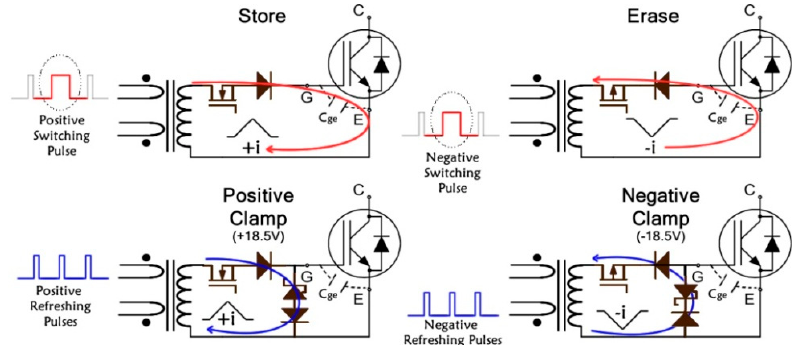
Figure 6. Gate storage characteristic due to its parasitic capacitance considering a turn-on or turn-off command through a double primary pulse transformer and, also, the clamping circuit setting the on and off levels of the gate voltage.